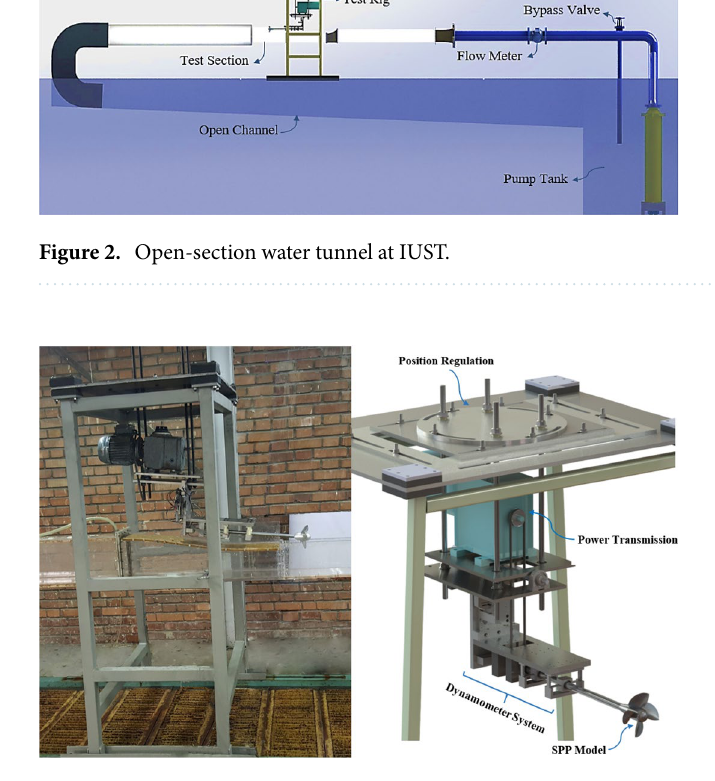
Figure 3. SPP test setup.